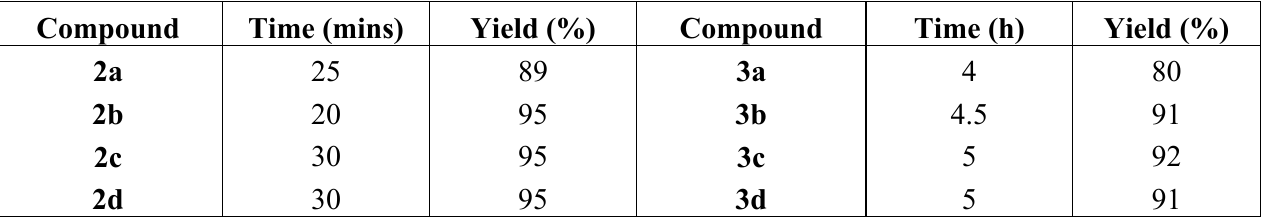
Table 1: Reaction Times and Yields of Schiff Base and Diamino Macrocycles